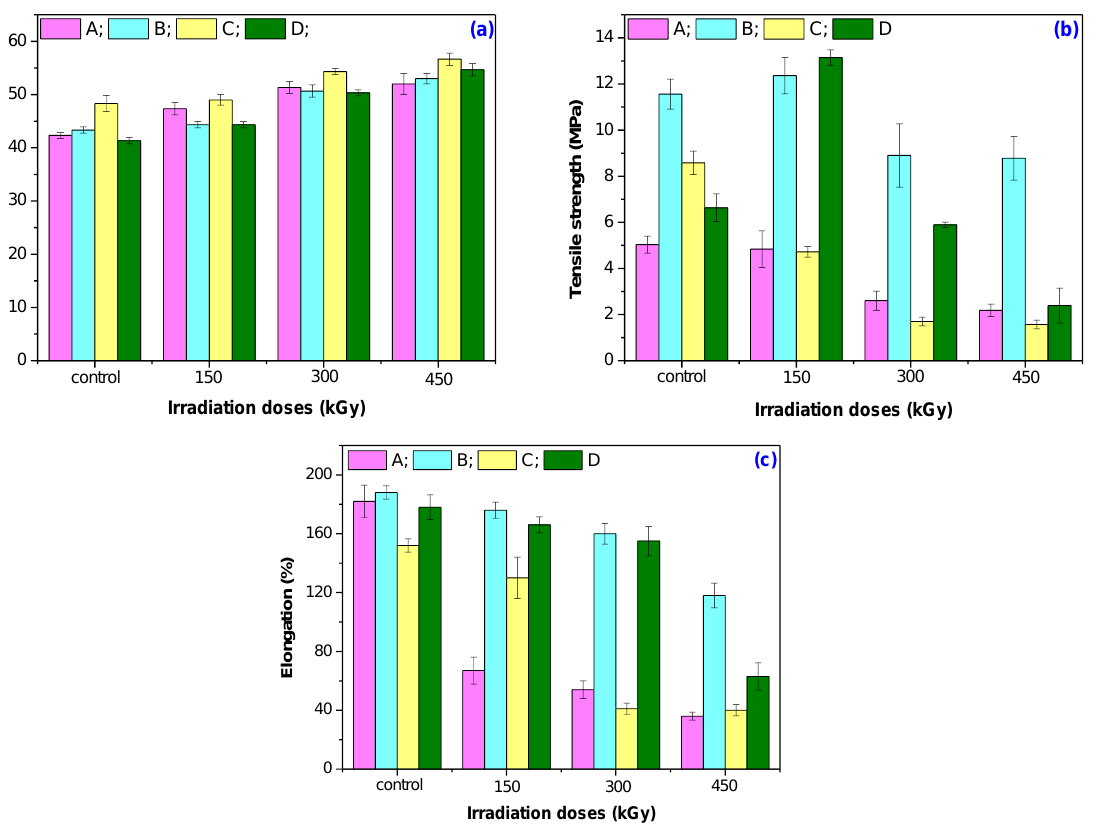
Figure 3. Hardness ( a ), tensile strength ( b ), and elongation ( c ) variation as a function of the electron beam’s irradiation dose. Table 5. Percentage modifications of mechanical properties of the samples after irradiation